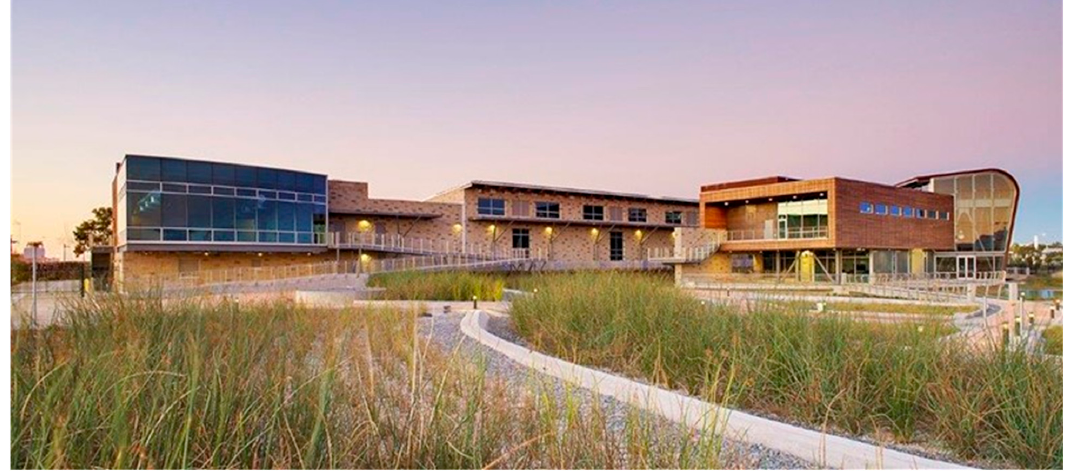
Figure 11. Construction of the constructed wetland around the visitor’s center of the AWPF.